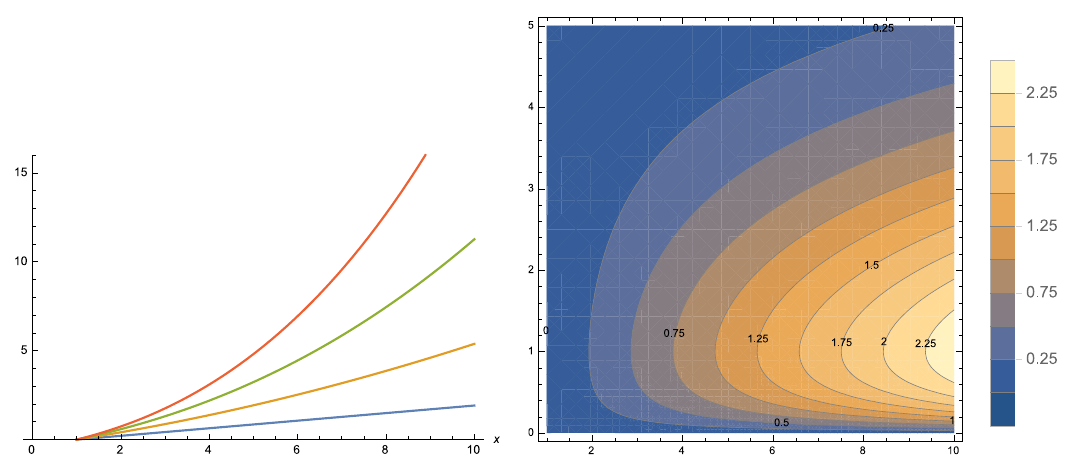
Figure 2. With reference to Example 1, left : plot of R t ( x ) for 1 < x < 10, with t = 1 and k = 2, 3, 4, 5 (from bottom to top); right : contour plot of R t ( x ) for 1 < x < 10 and 0 < µ < 5, with k = 2, t = 1 and λ = 1.